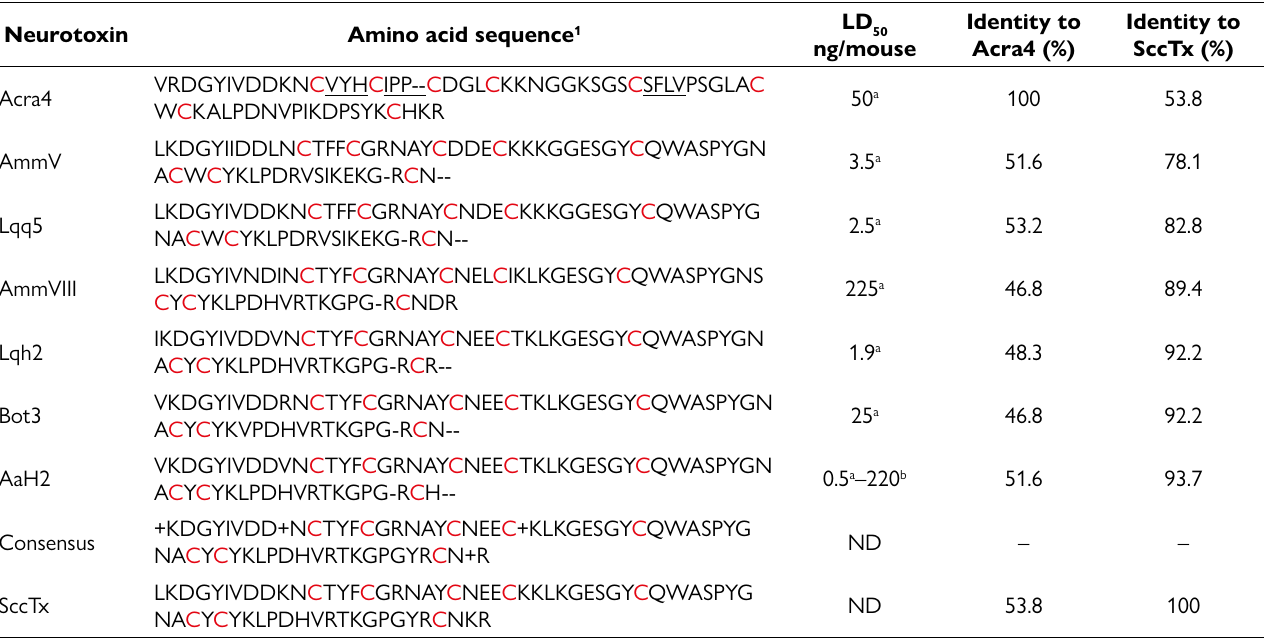
Table 1. Amino acid sequences, lethal dose, and identity of Acra4, SccTx and selected neurotoxins of scorpion venoms from North Africa and the Middle East.